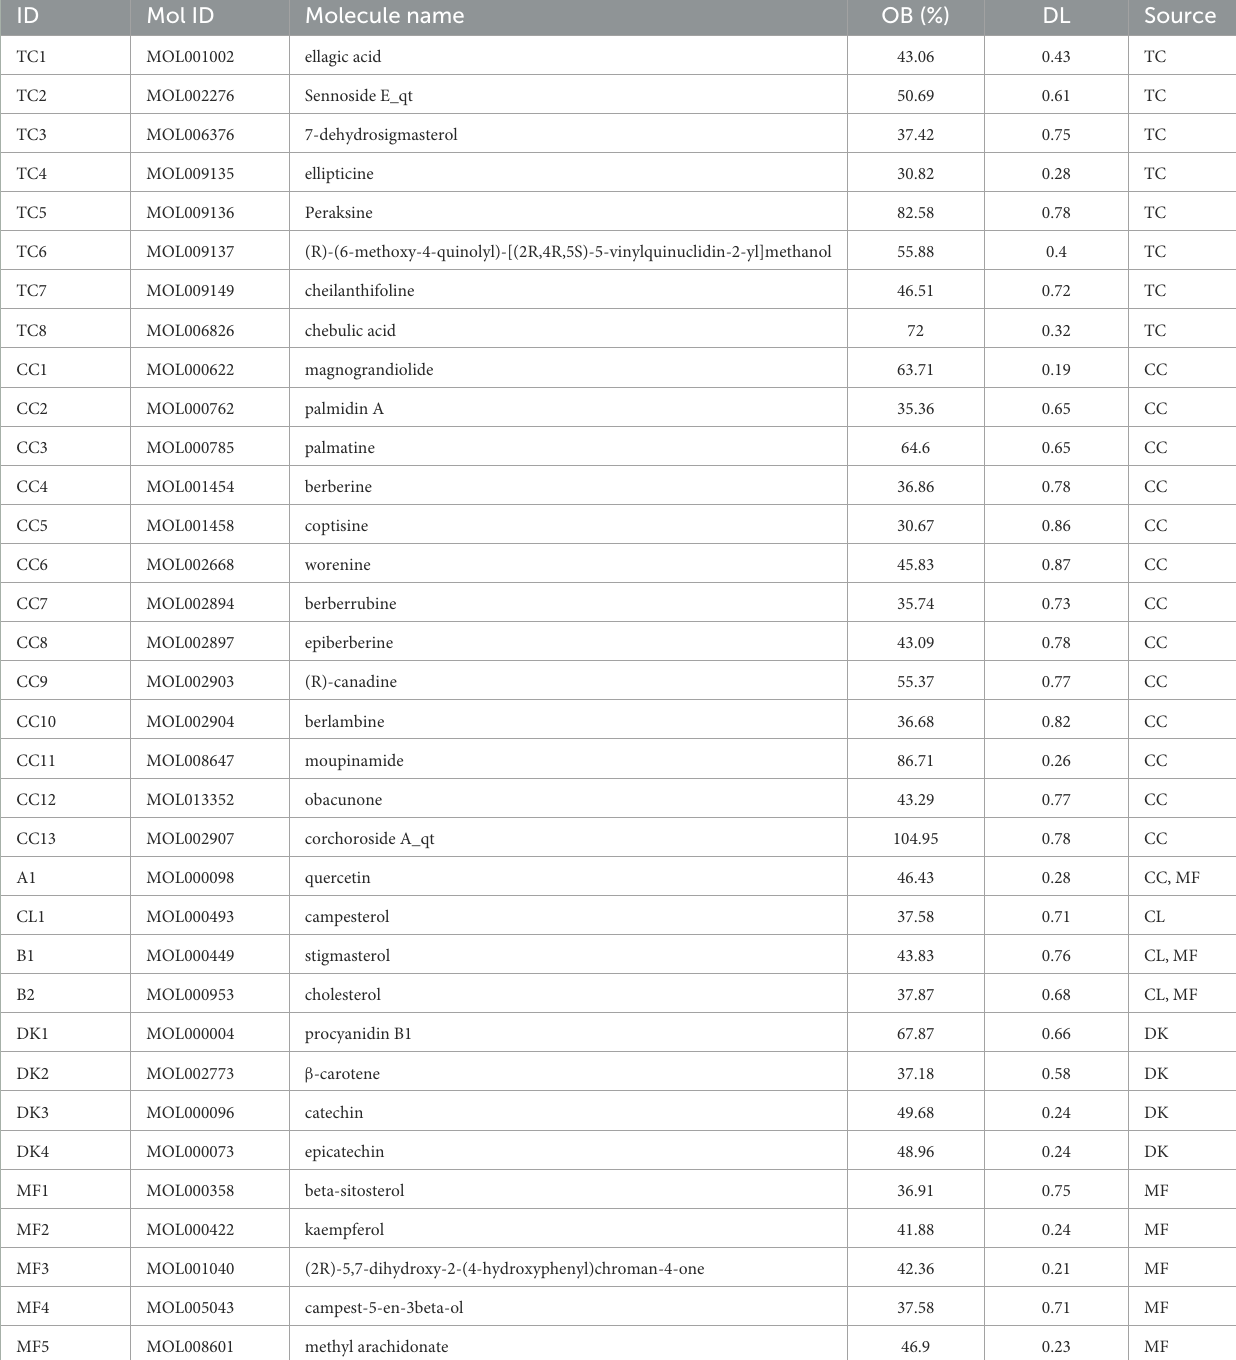
TABLE 1 Information of active ingredients in